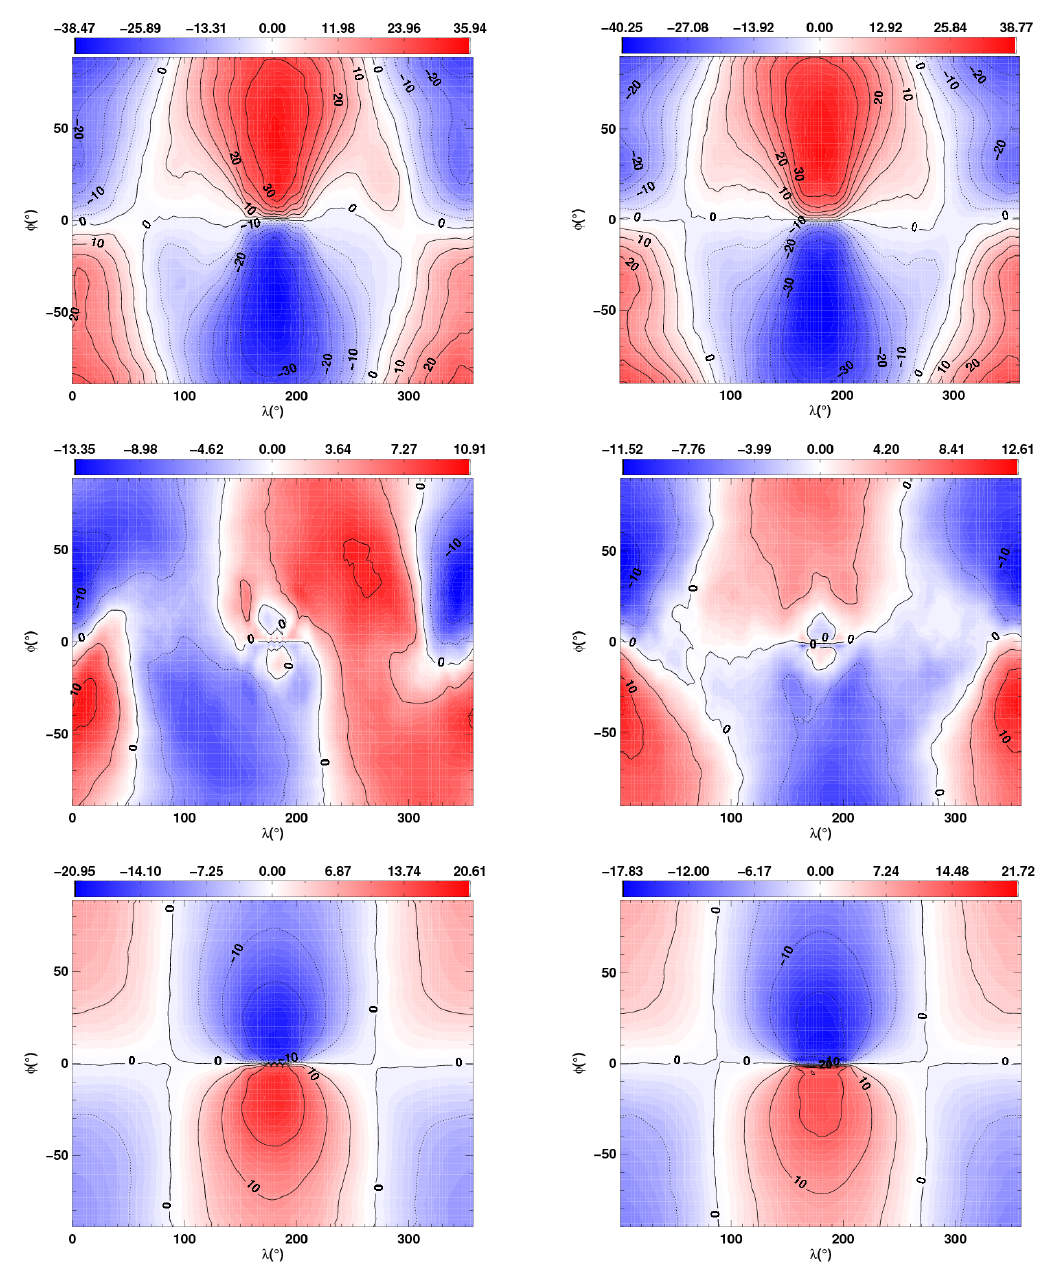
Figure 16. Figure showing, for the tidally locked Earth test (Merlis and Schneider, 2010; Heng et al., 2011b), (from the top panels to the bottom panels) the temporally averaged meridional wind at σ = 0 . 225, 0 . 525 and 0 . 975. Results are from the ND (left panels) and EG (right panels) models (see Table 2 for explanation of model types).